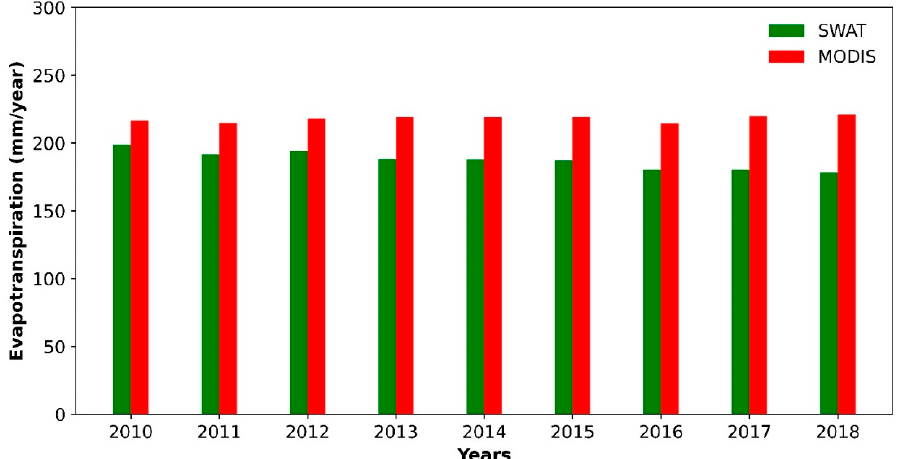
Figure 11. Comparison of annual SWAT-simulated vs. MODIS evapotranspiration data.